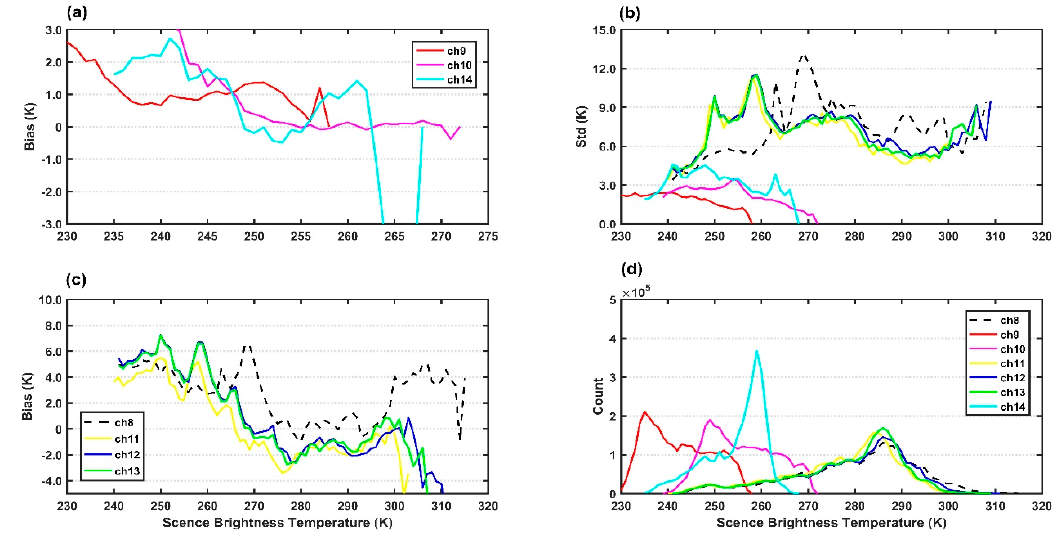
Figure 11. The dependence of ( a , c ) biases, ( b ) standard deviation and ( d ) count on scene brightness temperature (units: K) at 1 K intervals for AGRI data for channels 8–14 over ocean.